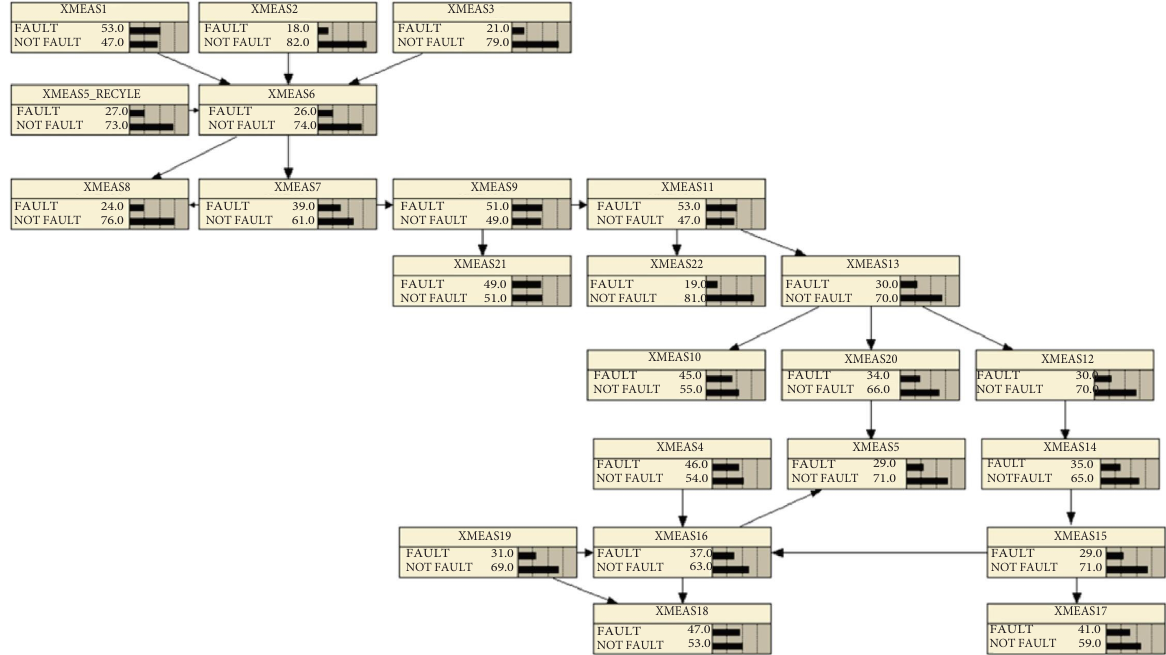
Figure 10: Bayesian network of TE chemical